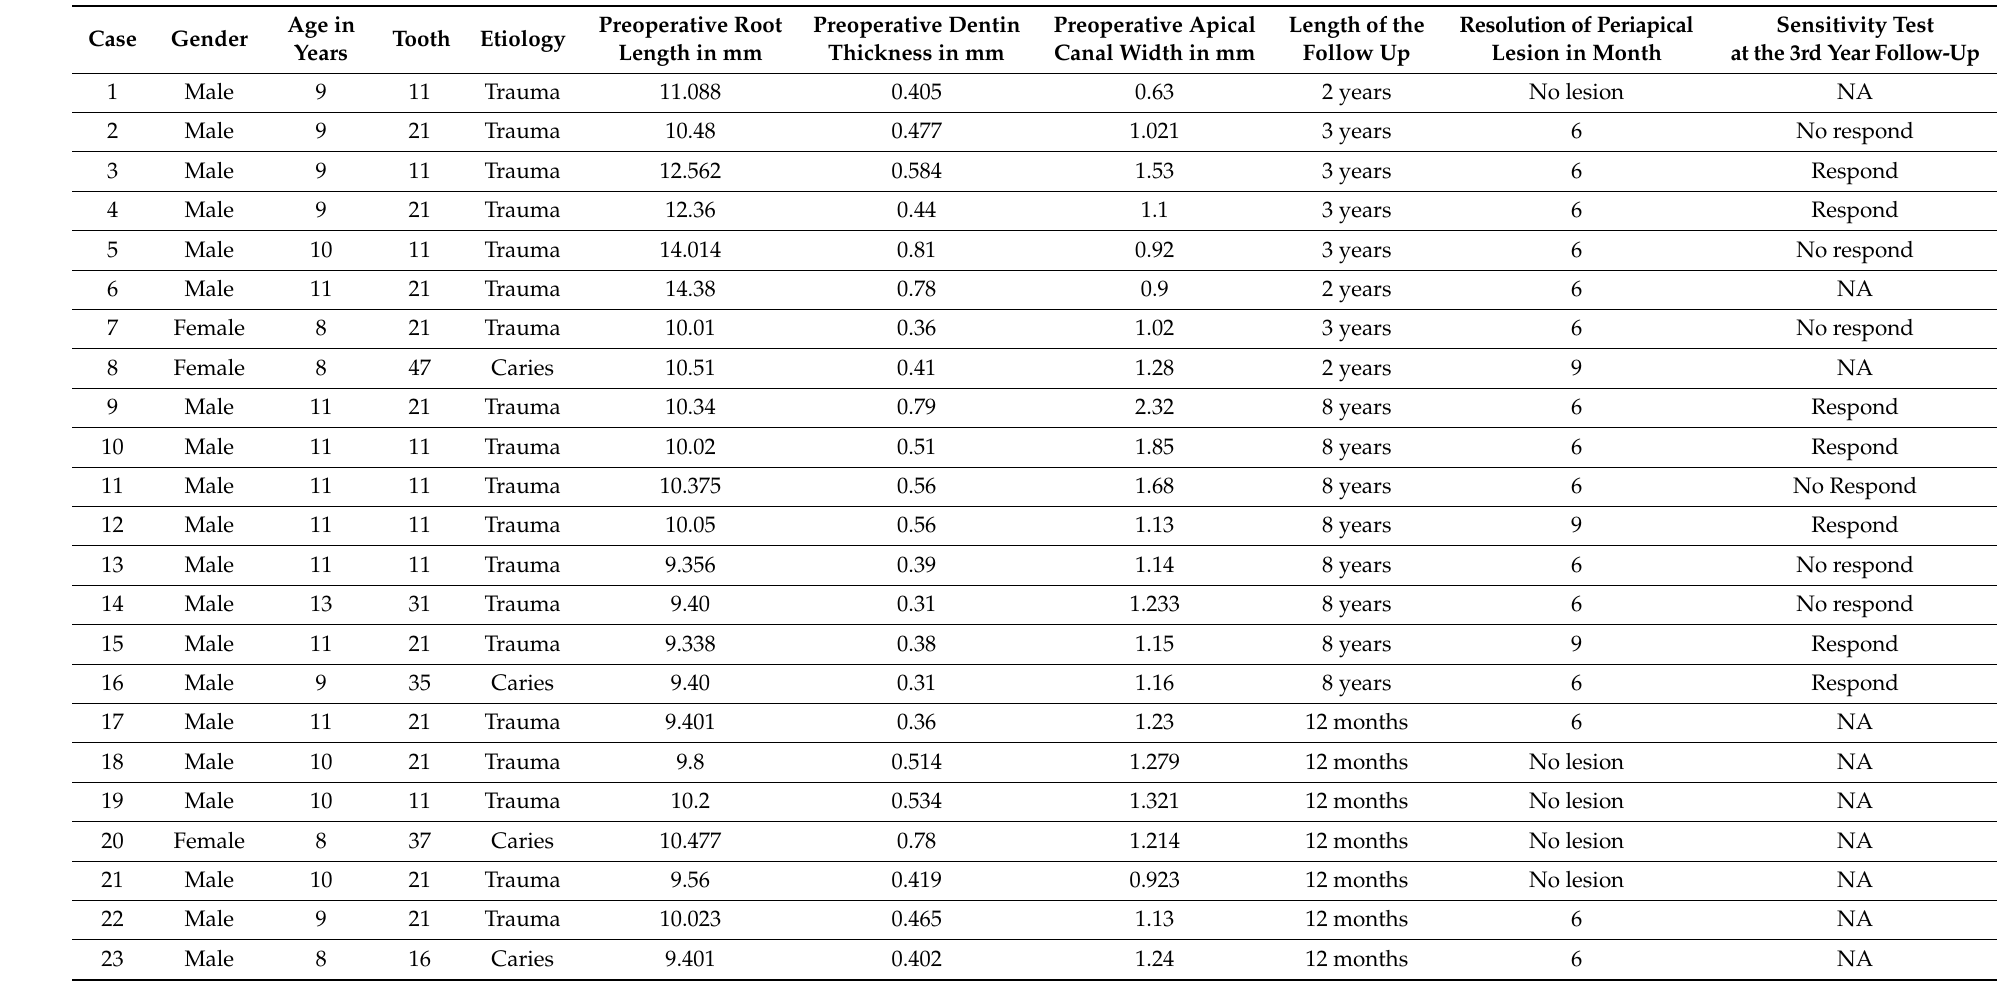
Table 1. Demographic data of the treated